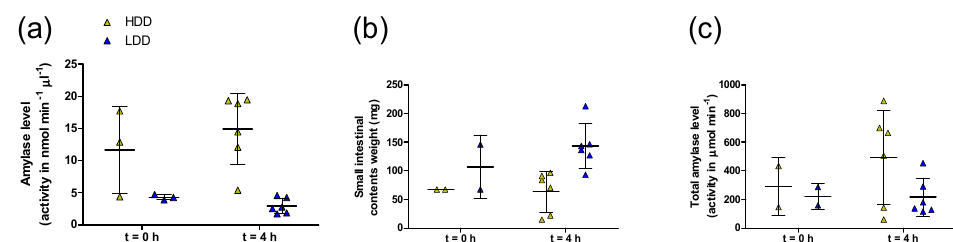
Figure 4. ( a ) Amylase levels, assayed as activity, per unit of small intestinal contents from HDD and LDD females in PW 4, without ( t = 0 h; n = 3) and 4 h after ( t = 4 h; n = 6) oral administration of a 13 C-labelled starch bolus. ( b ) Total weight of small intestinal contents from females in panel ( a ); note 1 missing value in each group ( t = 0 h) that failed to be recorded. ( c ) Estimated total amylase activity in the entirety of the small intestinal contents, based on data from panels ( a ) and ( b ). Data are presented as mean and SD. Student’s t -test. HDD, highly digestible-starch diet; LDD, lowly digestible-starch diet; PW, post-weaning week.